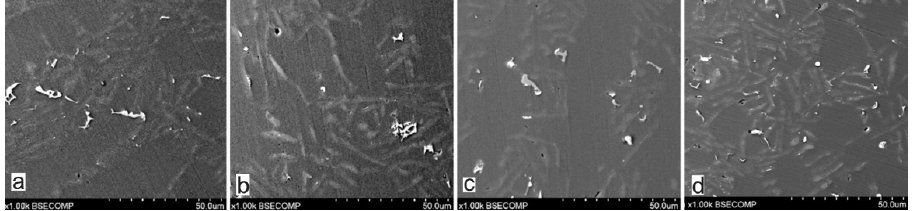
Figure 9. Microstructure of AlSi10 alloy with Sn addition (BSE—mag. 1000×): ( a ) AlSi10; ( b ) AlSi10Sn0.2; ( c ) AlSi10Sn0.4; ( d ) AlSi10Sn0.7.